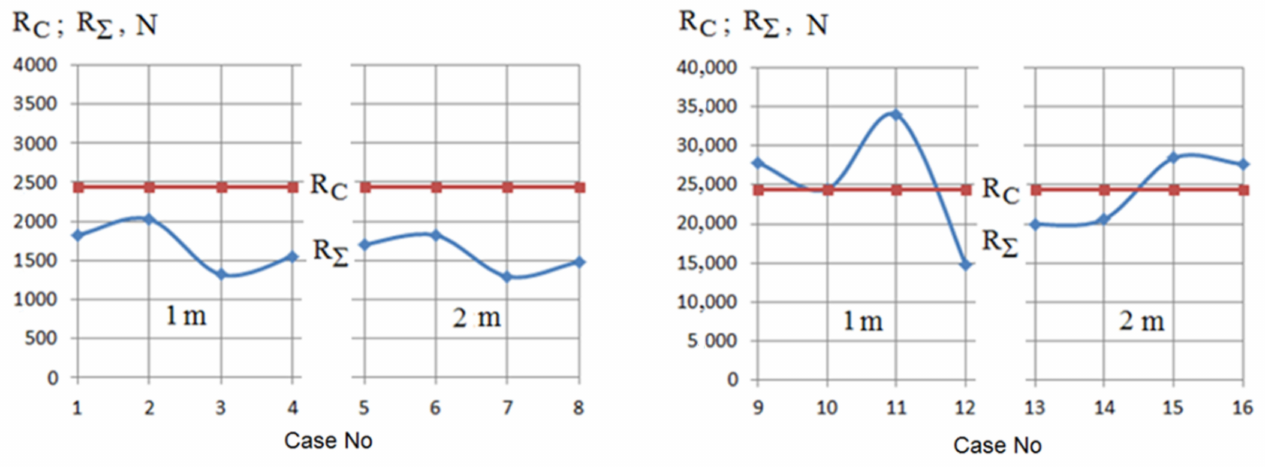
Figure 12. Total forces in various calculated cases (see Table